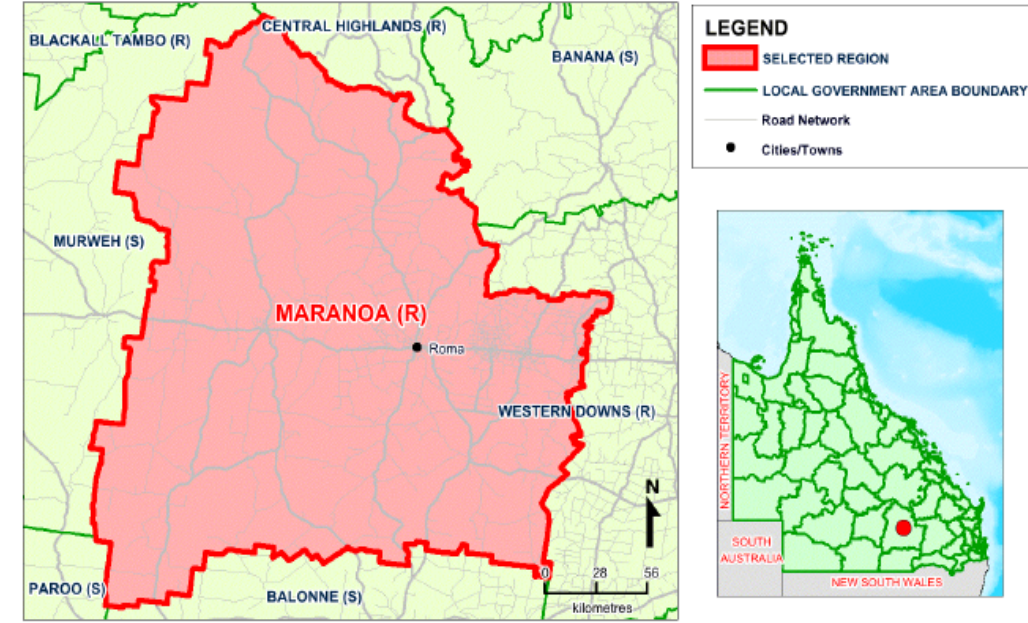
Figure 5. Map of Maranoa Regional Council [49].